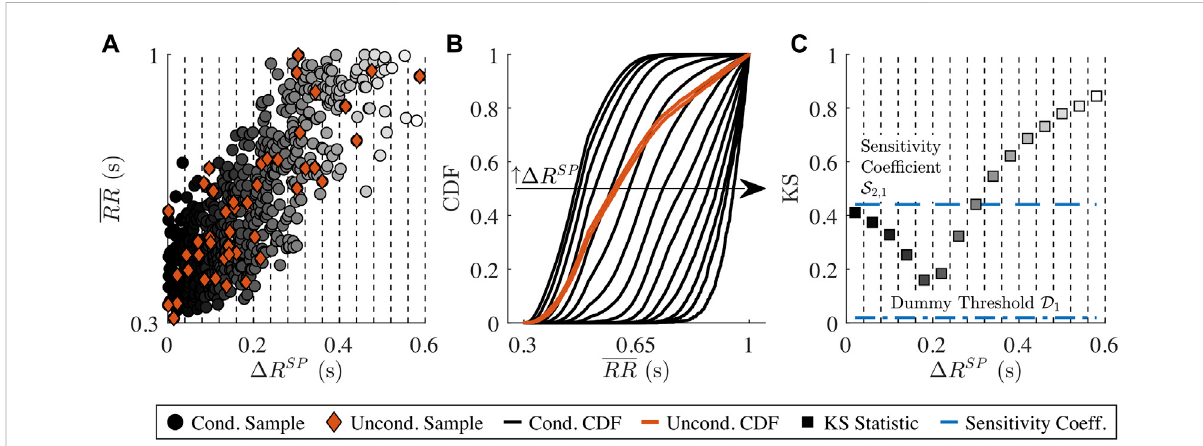
FIGURE 2 Illustration of the distribution-based sensitivity analysis. (A) RR plotted against one of the model parameters Δ R SP . The samples that are used to estimatetheconditionalCDFs F y m | x n ( y m | x n ∈ I c ) areillustratedascirclesandtheconditioningintervals I c areillustratedwithverticaldottedlines.The ( y m ) are illustrated as diamonds. (B) F y ( y m | x n ∈ I c ) are illustrated as black lines, samples that are used to estimate the unconditional CDF F ( d ) y m | x n m where the leftmost line corresponds to F y m | x n ( y m | x n ∈ I 1 ) with the lowest Δ R SP values and the rightmost line corresponds to F y m | x n ( y m | x n ∈ I 15 ) . ( y m ) lay all within the area illustrated by the red patch. (C) Each of the 15 squares correspond to The 1,000 F ( d ) y m median